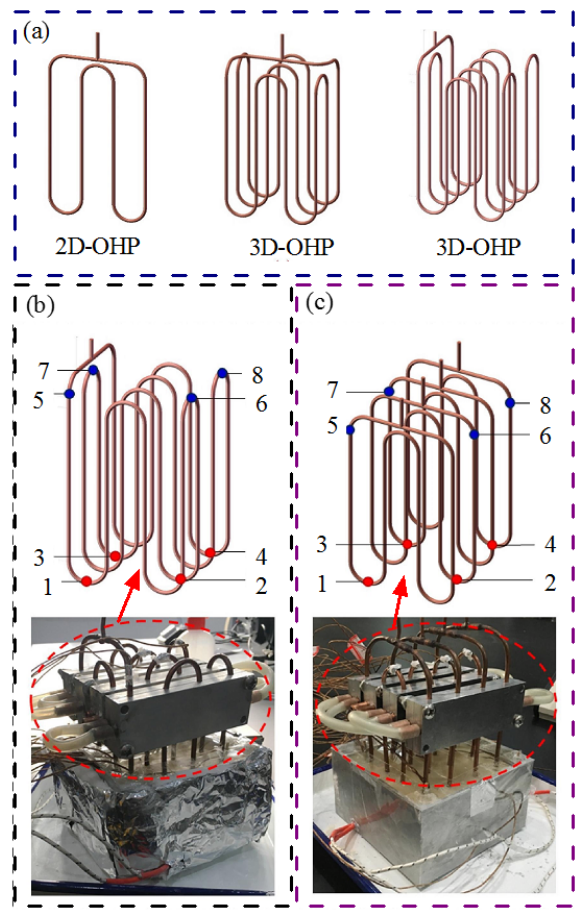
Figure 13. Schematic diagram of ( a ) 2D-OHP, 3 layers 3D-OHP and 4 layers 3D-OHP; Experimental system diagram of ( b ) 4 layers 3D-OHP and ( c ) 4 layers 2D-OHP, where 1~8 are the positions of thermocouples [130]. Qu et al. (2019). (The dotted circles is the test area).